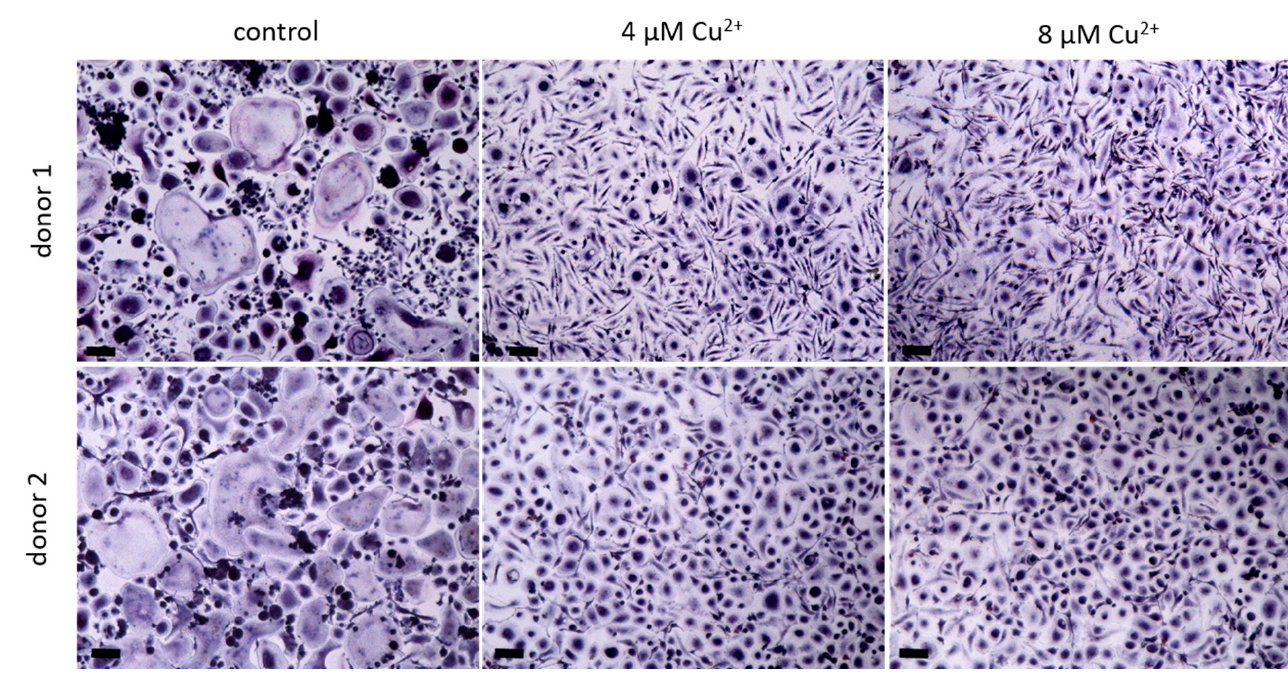
Figure 2. Osteoclasts were differentiated from PBMC for 14 days in the presence of MCSF and RANKL and without Cu 2+ (control) as well as under the addition of 4 and 8 µM Cu 2+ , light microscopy after staining of TRAP (pink) and nuclei (blue), scale bars represent 100 µm.